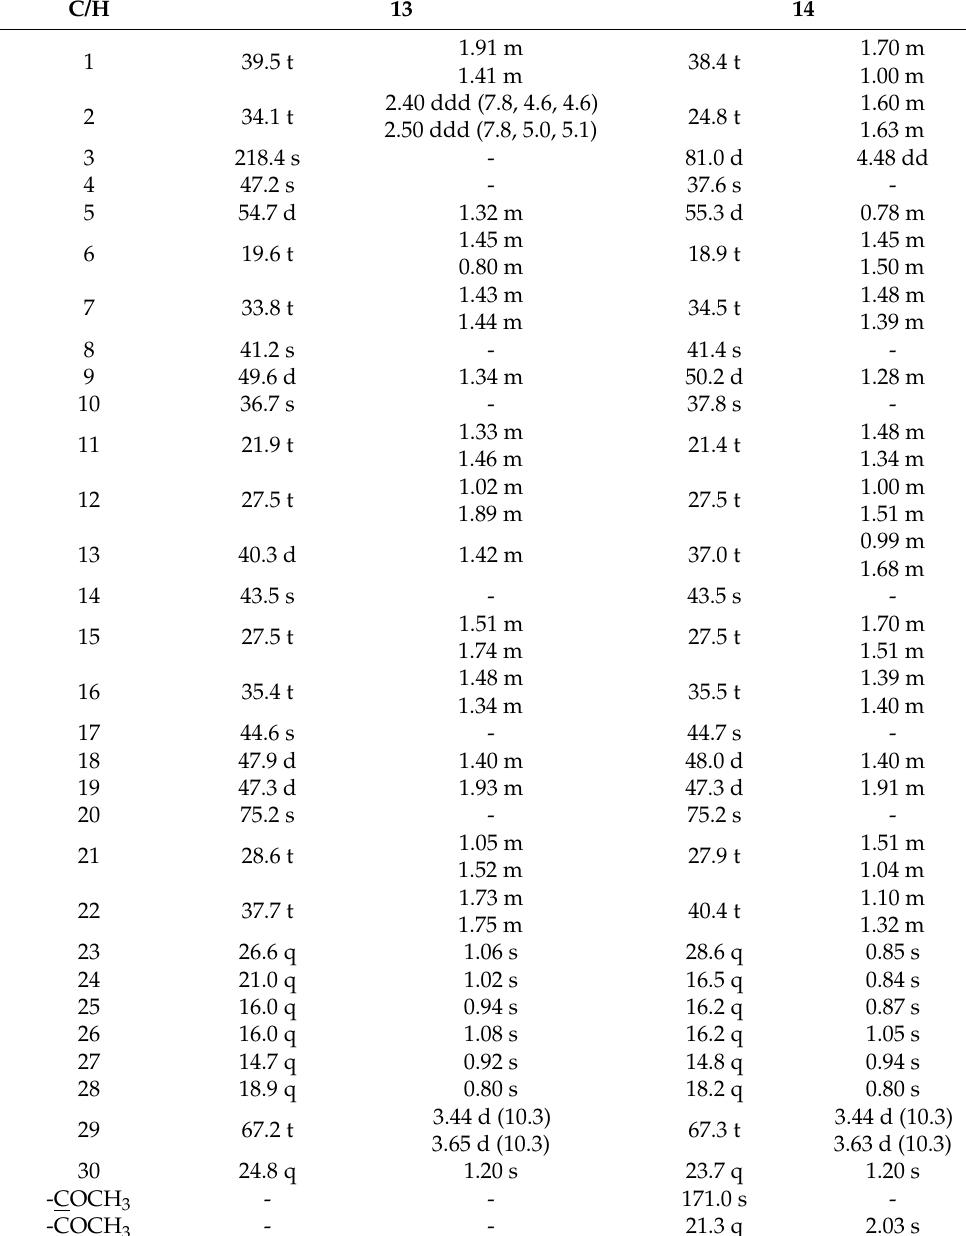
Table 2. 1 H and 13 C NMR spectral data of the new compounds 13 and 14 in CDCl 3